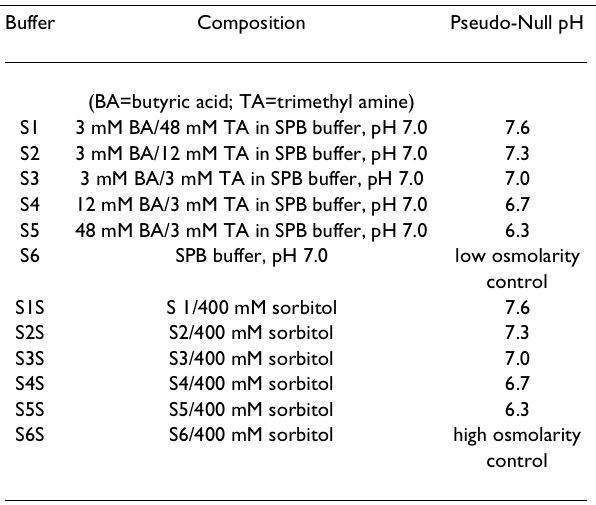
Table 1: Buffers used in the Pseudo-Null Point pH determination